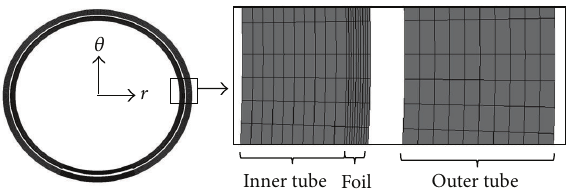
Figure 2: Finite element mesh used in the three-step